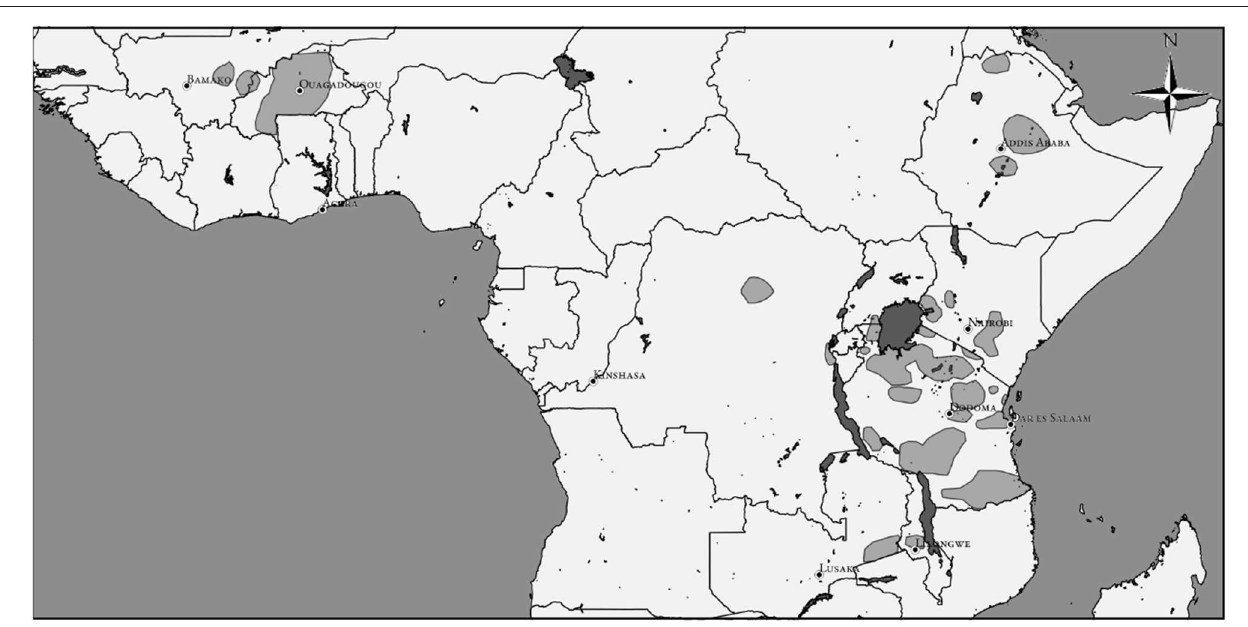
FIGURE 1 | Coverage of sampled locations within countries—represented by shaded areas.